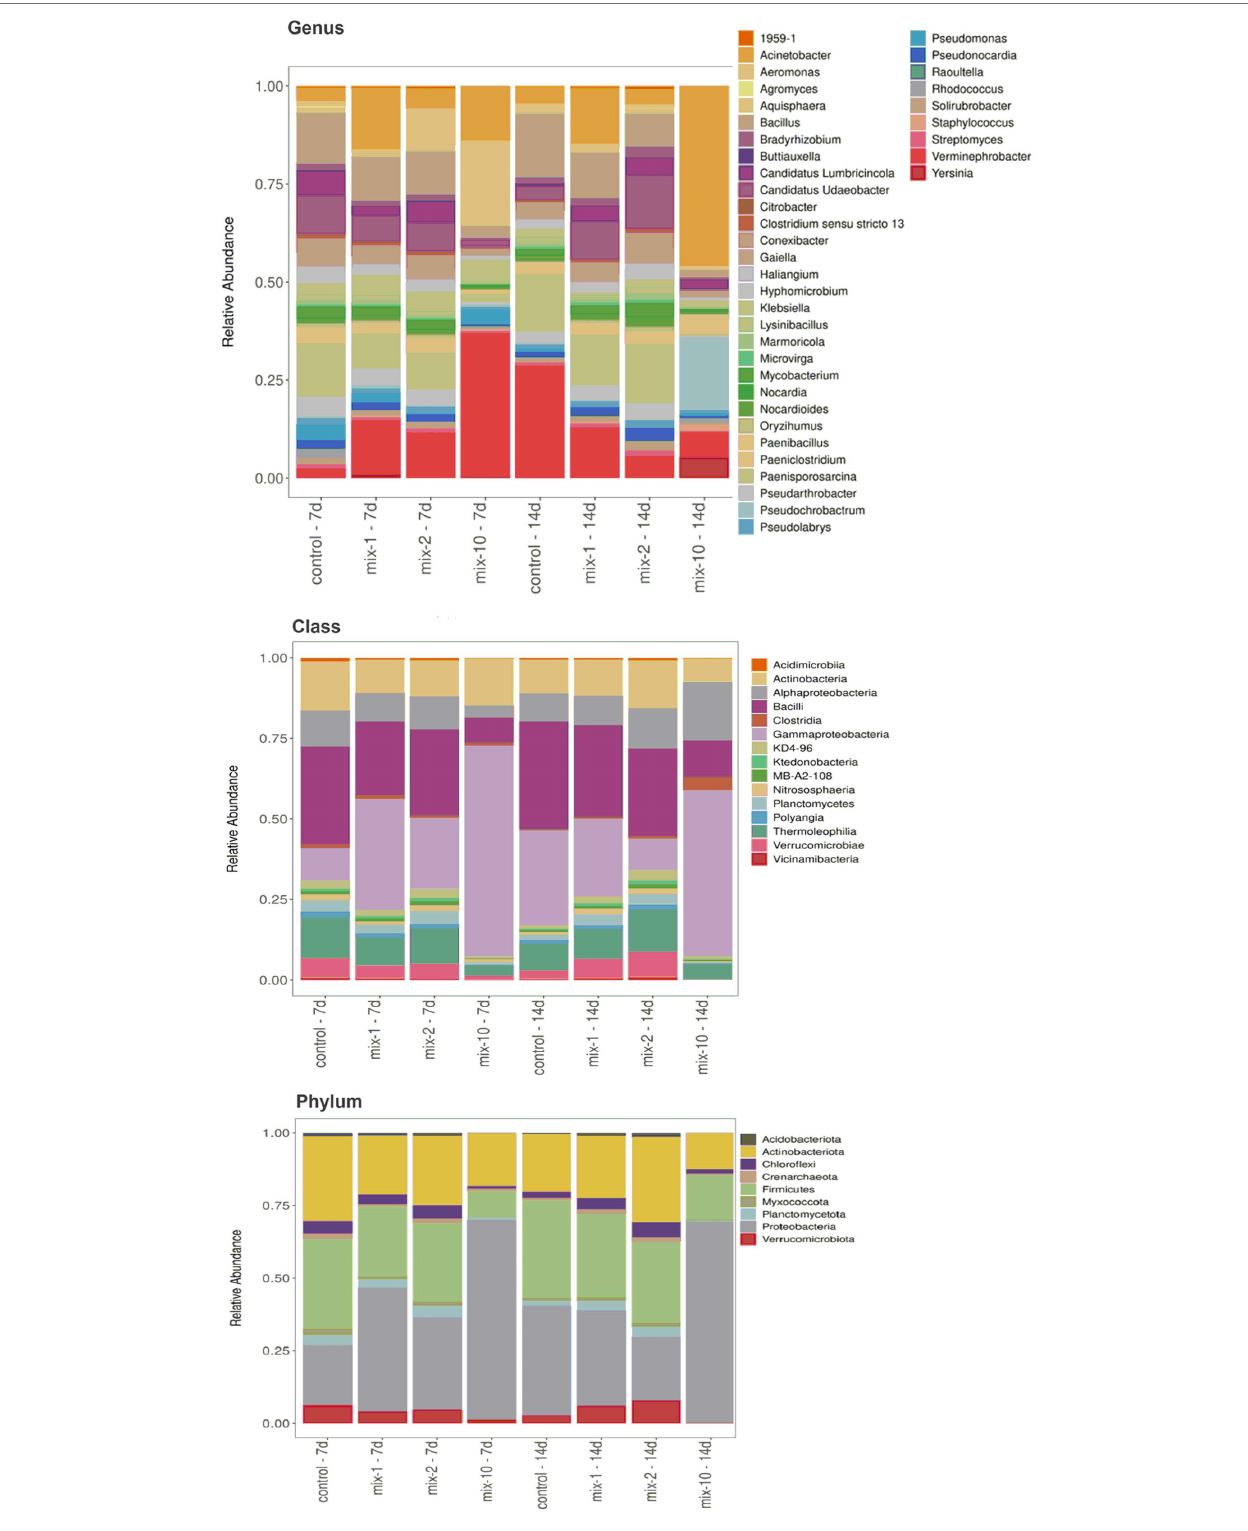
FIGURE 3 | The structure of the prokaryotic community of the intestinal tract of L. terrestris at the levels of phyla, classes and genera ( N = 2). Legend: mix indicates pesticides in a mixture; 1/2/10 is the recommended, 2-fold and 10-fold pesticide application rates; 7 day/14 day is the incubation time. The relative abundance is shown for taxa with read counts